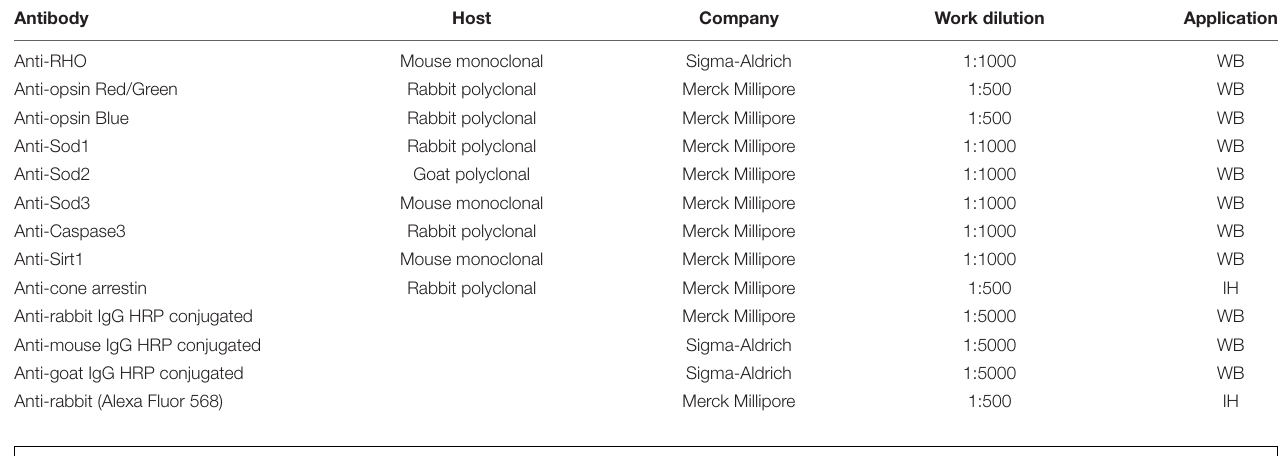
TABLE 1 | List of antibodies for Western blotting and immunohistochemistry.